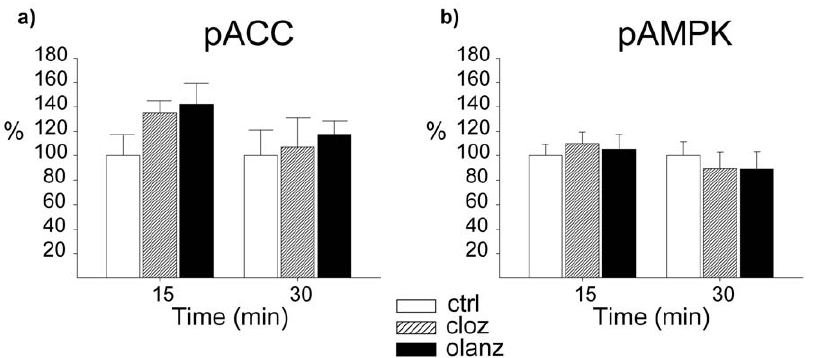
Figure 2. Effect of IP olanzapine and clozapine administration on phosphorylation of hypothalamic AMPK and ACC. Western blot analysis of hypothalamic levels of a) pACC or b) pAMPK in rats following IP injection of vehicle (ctrl) olanzapine (olanz; 10 mg/kg), clozapine (cloz; 25 mg/kg). Protein levels were normalized against b -actin as the endogenous control. Statistical calculations were based on results from n=6 rats in each control group. * P # 0.05 vs. vehicle. ** P # 0.01 vs. vehicle. *** P # 0.001 vs.